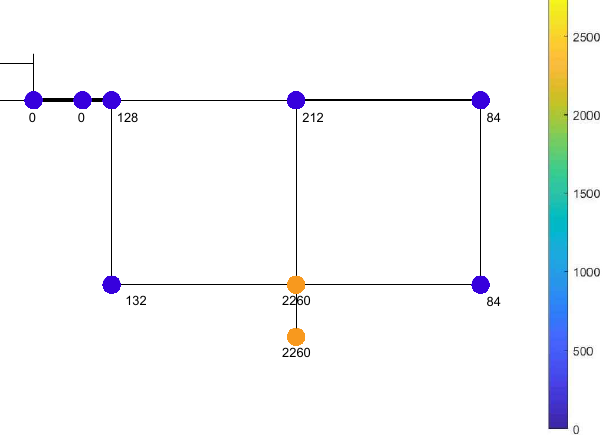
Figure 10. Map of vulnerability evaluated by the LM for a numerical test equivalent to test #1, but with a diameter distribution reversed with respect to the laboratory layout (numbers at nodes indicate the value of the index of vulnerability, V